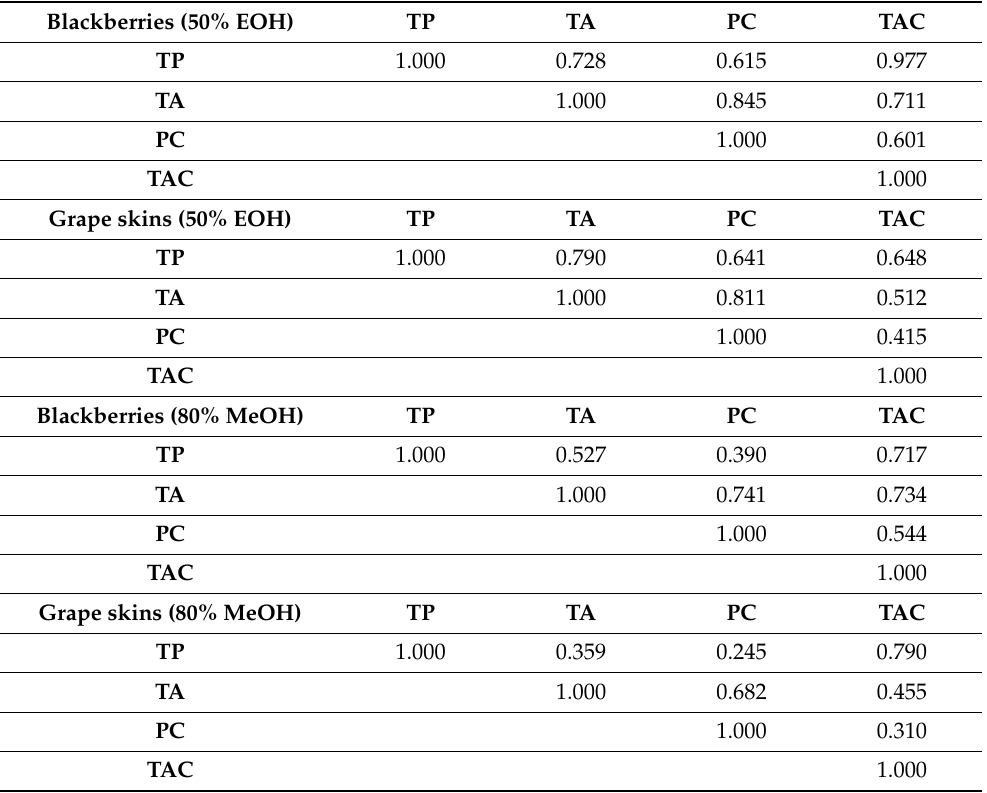
Table 3. Pearson’s correlation coefficients for total phenolic content (TP) and antioxidant